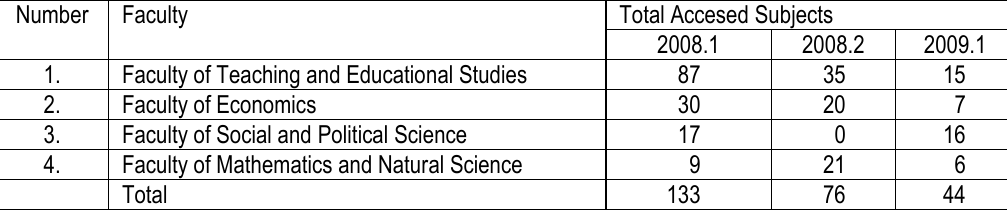
Table 2. The Recapitulation of Subject Accessed by Faculty in Year